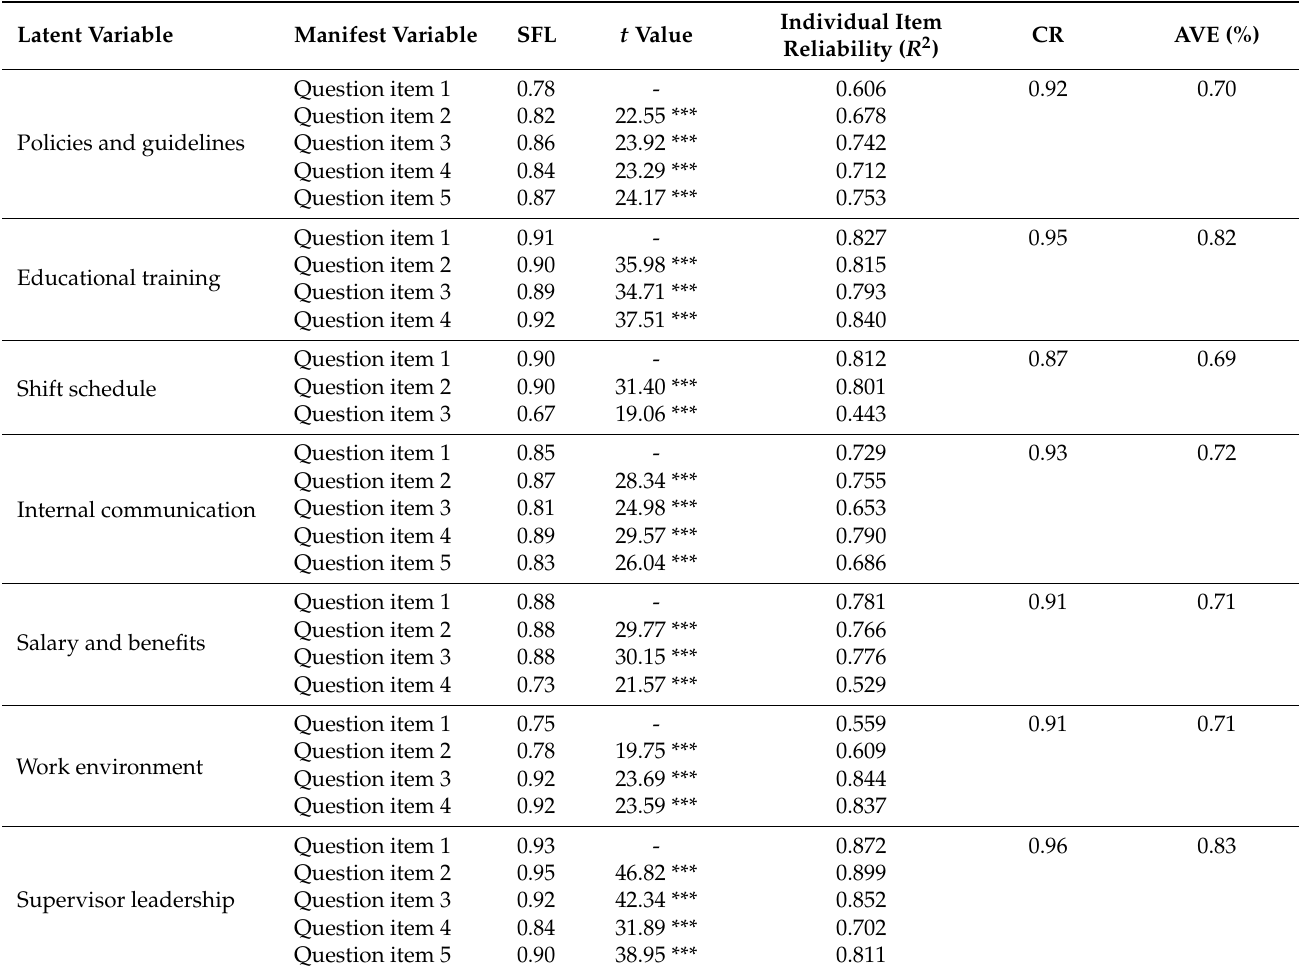
Table 2. Confirmatory factor analysis results for each